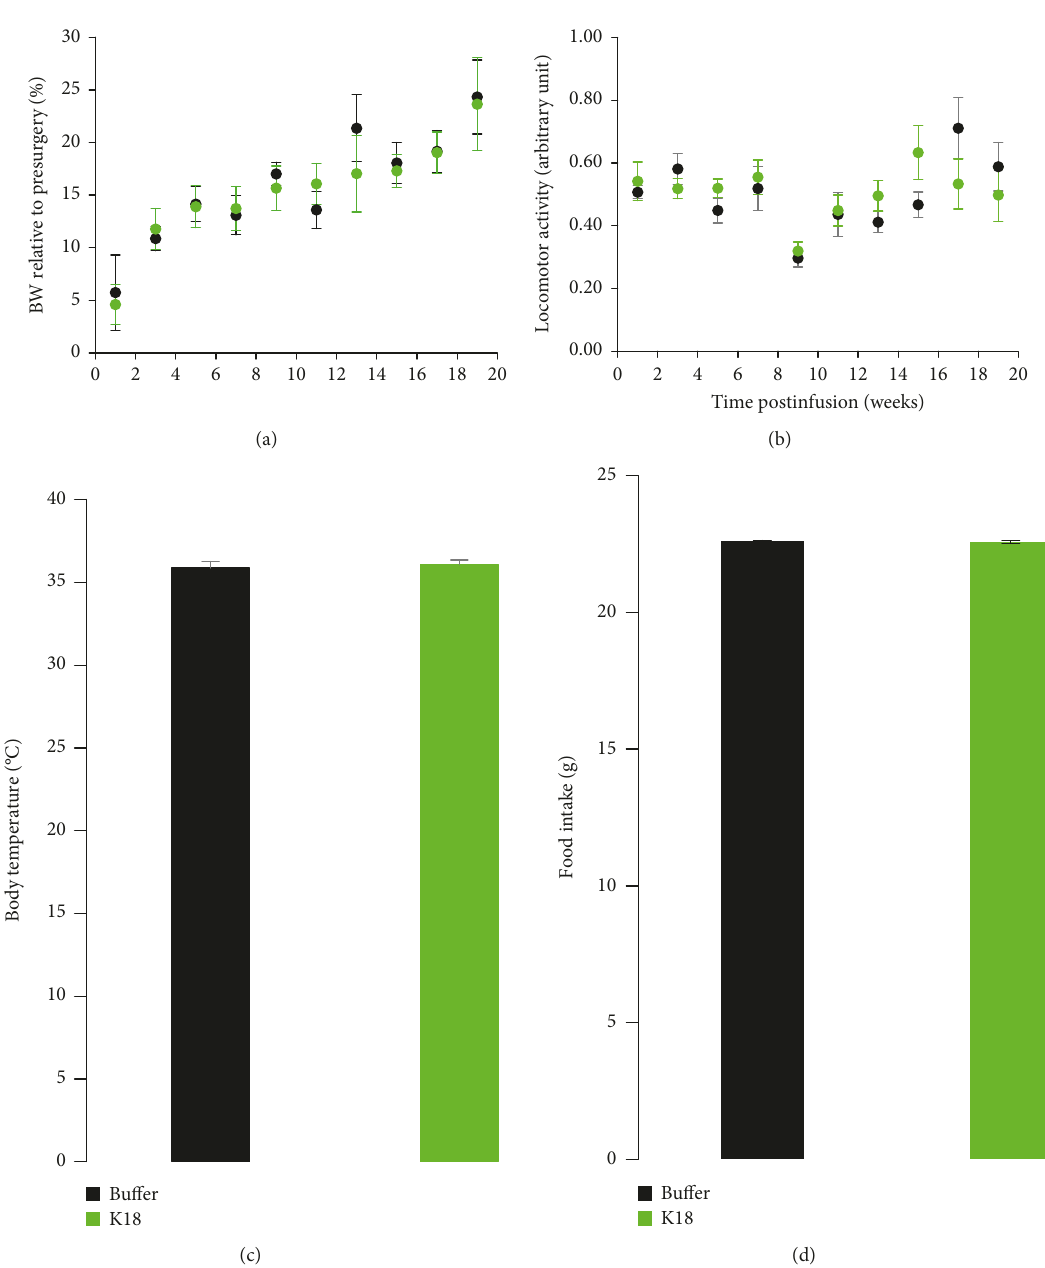
Figure 4: Mean locomotor activity, body weight, body temperature, and food intake in bu ff er- (black, n = 7 ) and K18- (green, n = 8 ) injected mice. (a) Body weight relative to presurgery and (b) locomotor activity were monitored daily prior and during EEG recording sessions, respectively. (c) Body temperature was measured in the middle of the study, and (d) food intake was measured daily during the fi rst week postinfusion of K18 and bu ff er in the LC area. No changes in the mean activity levels, body weight, body temperature, and food intake were observed between the study groups. Data are expressed as mean ± sem